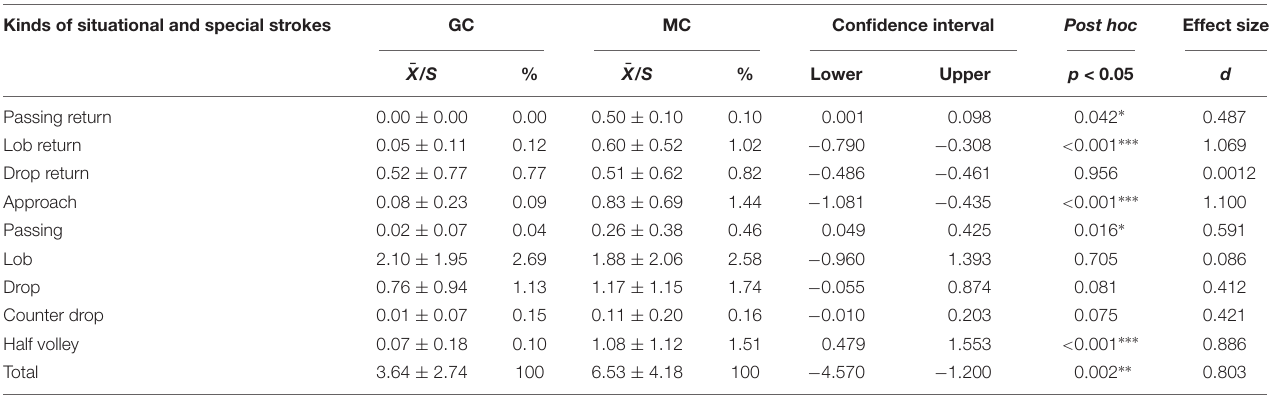
TABLE 3 | Descriptive values (mean, standard deviation, and percentage) and analysis of variance (Student’s t -test for paired samples) of the “situational and special strokes” per match. Kinds of situational and special strokes